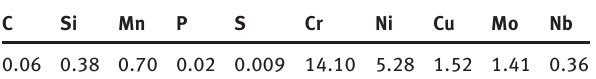
Table 1: Chemical composition (in wt.%) of FV520B steel C Si Mn P S Cr Ni Cu Mo